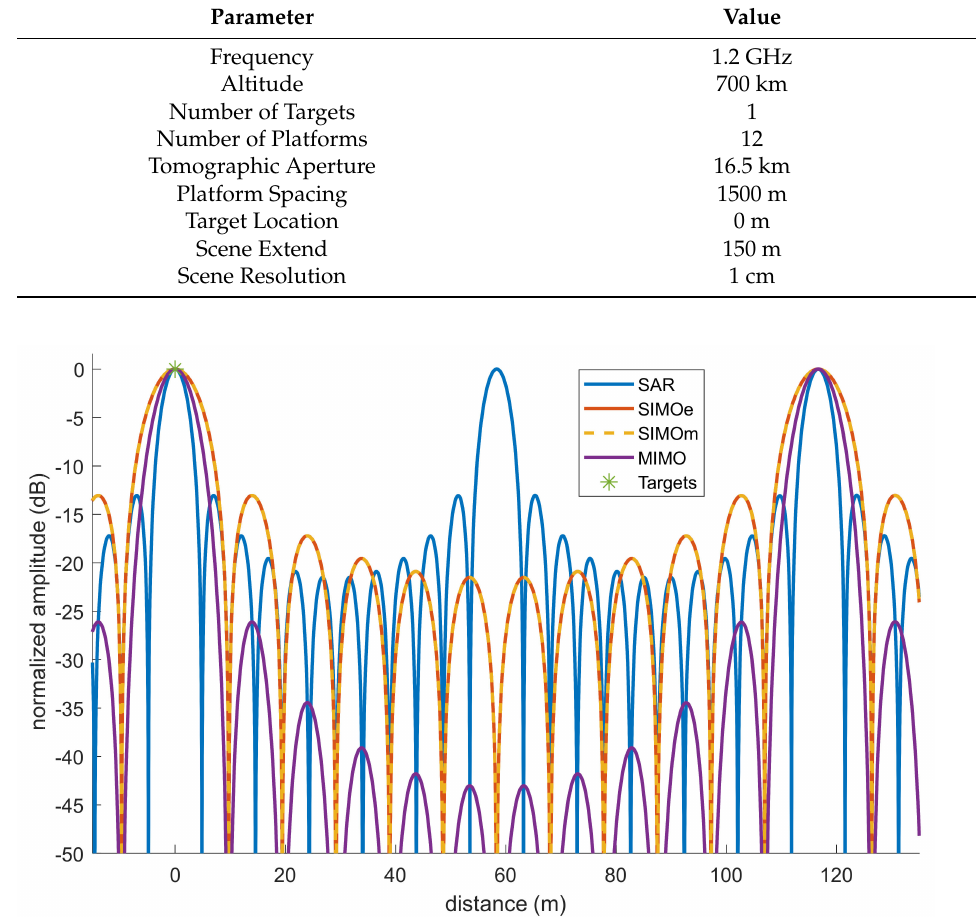
Figure 15. Tomographic “images” in 1D for the SAR, SIMO, and MIMO modes. Green asterisk shows the position and intensity of the point target at